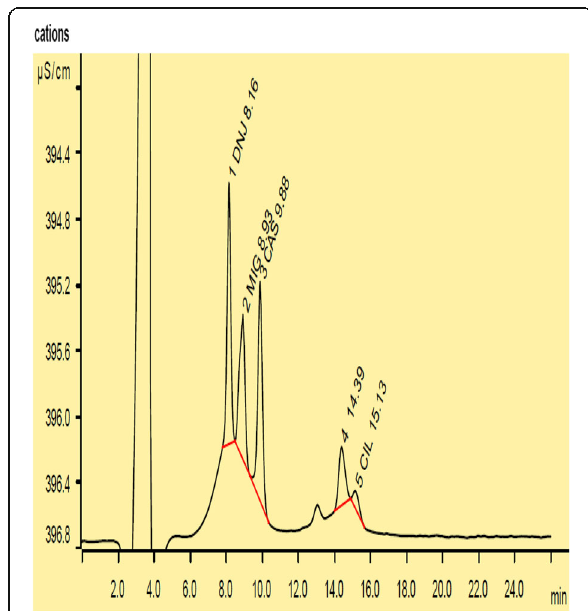
Fig. 4 Blend chromatograms of selected Aza sugars (1- deoxynojirimycin, miglitol, castanospermin, and celgosivir) with Metrosep C4 150/4.0